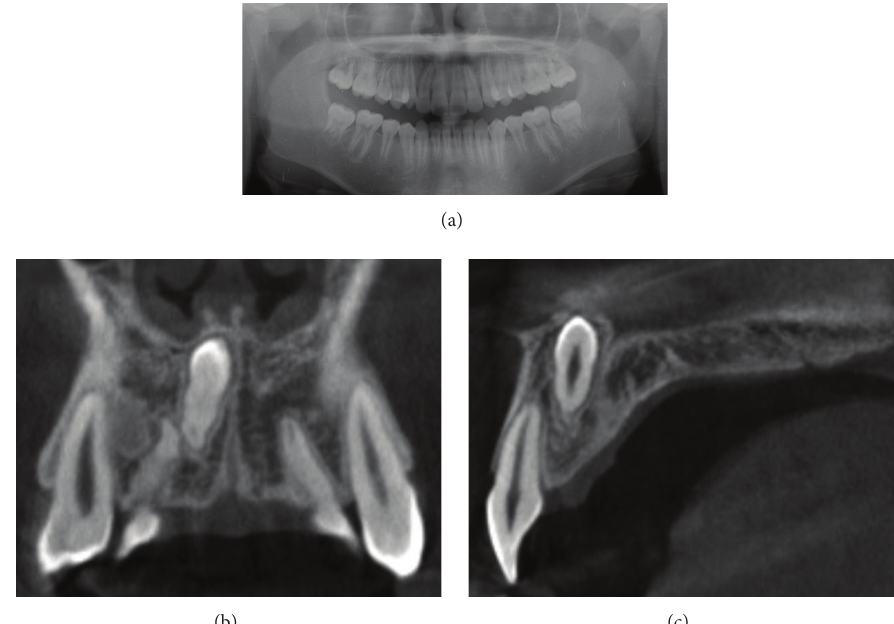
Figure 1: (a) Orthopantomograph X-ray and (b) coronal and (c) sagittal computed tomography images showing a deeply impacted supernumerary tooth in the anterior maxilla. The crown of the tooth was exposed on the nasal cavity